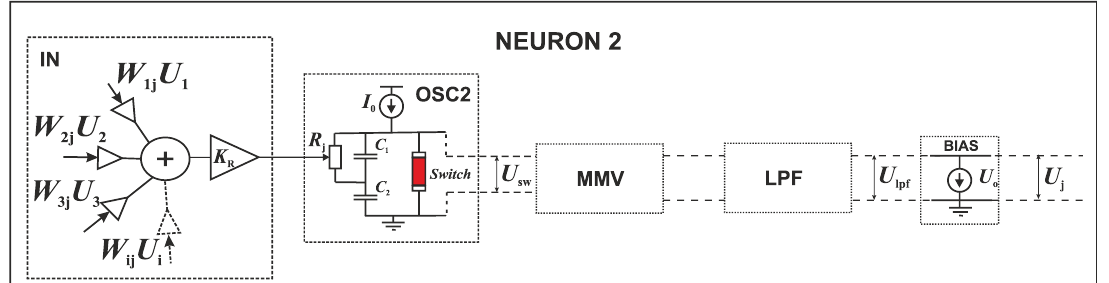
Figure 7. LIF scheme of a neuron (Neuron 2) based on